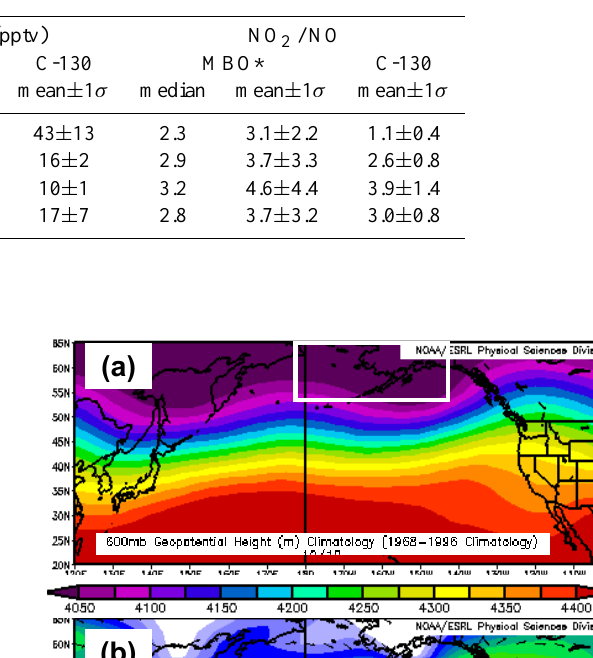
Table 4. Comparison of MBO data to data collected aboard the NCAR C-130 aircraft during fly-by’s of MBO as part of the INTEX-B campaign in spring 2006. The column denoted with an asterisk (*) indicates that 2007–09 median or mean NO 2 (and NO) values for the hour of day and the month in which the fly-by occurred are used since NO 2 measurements were not made at MBO until 2007. C-130 aircraft data provided by Gao Chen (at NASA) and is presented as the median of the 1s data within 25km of MBO horizontally and within 100m of its summit.